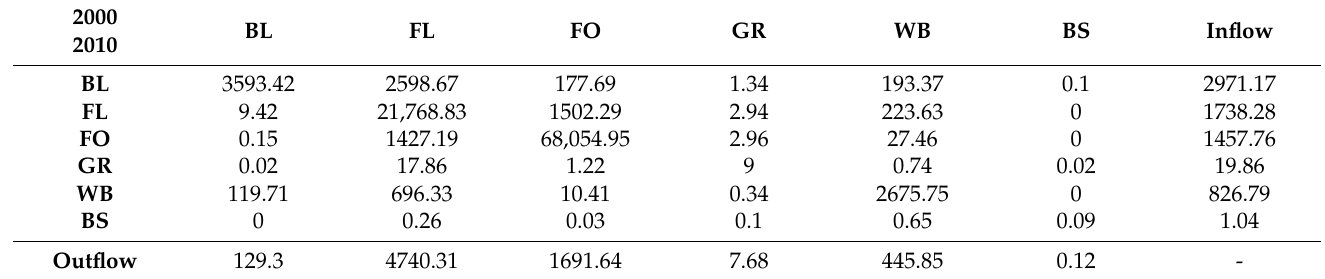
Table 5. Transfer matrix of land use change in Zhejiang Province from 2000 to 2010 (km 2 ).